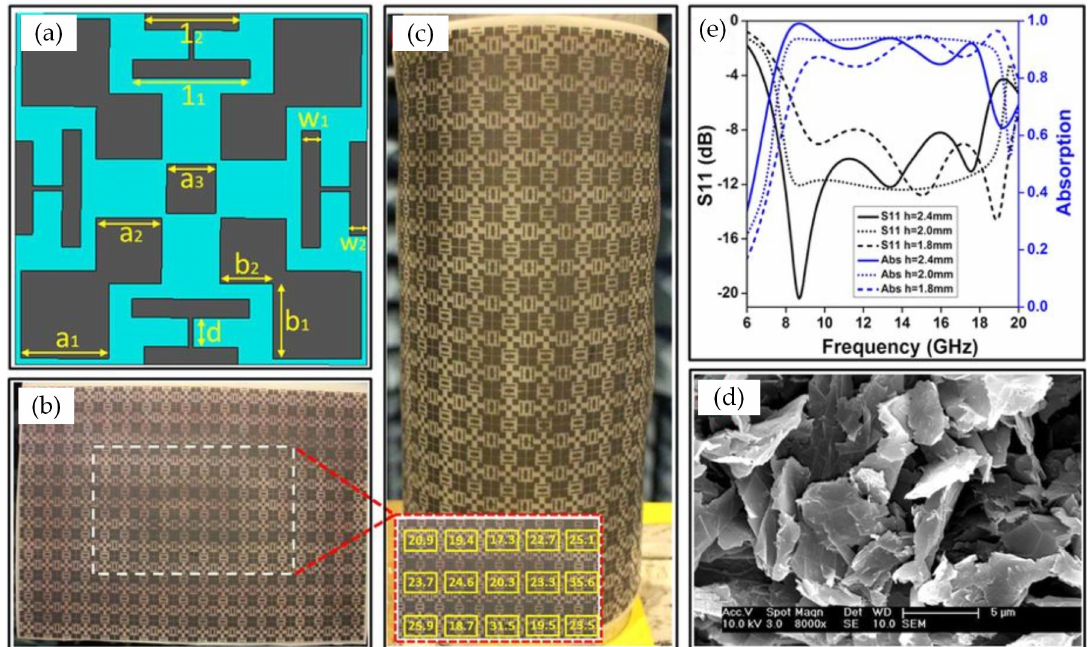
Figure 9. ( a ) schematic of the unit cell; ( b ) image of the fabricated absorber; ( c ) absorber coated on the surface of metallic cylinder; ( d ) SEM image of the printed graphene; ( e ) measurement results of the graphene metasurface absorber, reprinted with permission from Ref.